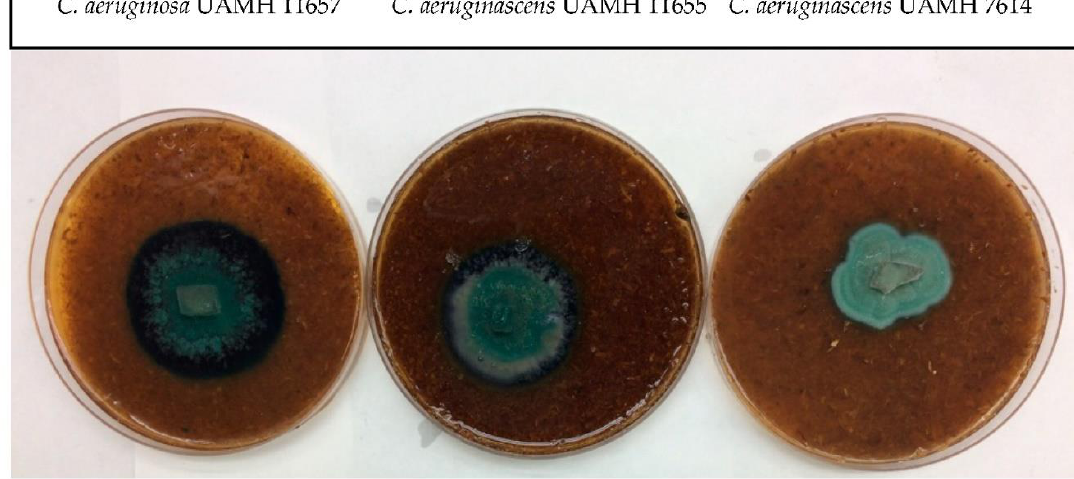
Figure 6. Woodchip-amended lab-grade malt media plate cultures of species and strains at 9 weeks of growth.